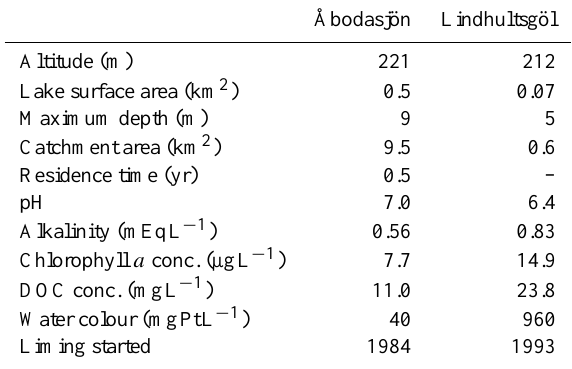
Table 1. Morphometric and hydrological characteristics of the two study lakes, sampled in July 2007 (von Einem and Granéli, 2010).